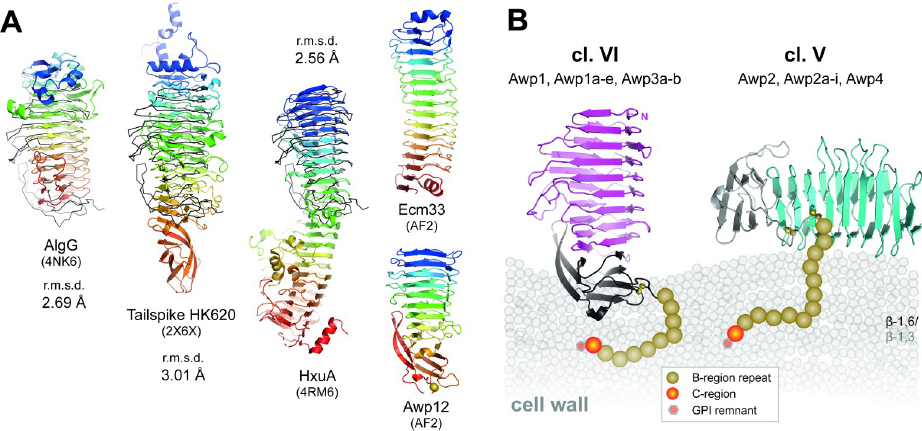
Fig 8. Structural relationships and predicted arrangement on glycan cell wall of Awp1-related adhesins. (A) Structural superposition of the Awp1 A-region (black ribbon) and three bacterial right-handed β -helix proteins colored from the N-terminus (blue) to the C-terminus (red): The periplasmic alginate epimerase AlgG from Pseudomonas syringae , the tailspike protein from the E . coli bacteriophage HK620 and the hemopexin binding protein HxuA from Haemophilus influenzae . The r.m.s.d. values after superposition were calculated for the respective β -helix domains by PDBeFold [27]. Right, Alphafold2 models of the Ecm33 domain from S . cerevisiae (Uniprot entry P38248, residues S28-S362) and Awp12 from C . glabrata CBS138 (Q6FSI9, D20-C314). (B) Predicted association modes of the A-regions of cluster V and VI adhesins to the cell wall of C . glabrata . The repetitive, highly O-glycosylated repeats of the B-region are schematically depicted as spheres (ochre). The C-region (red) of these C . glabrata GPI-CWPs links the cell wall proteins via a GPI-remnant (hexagon, orange) to the outer β -1,6-glucan layer (grey).